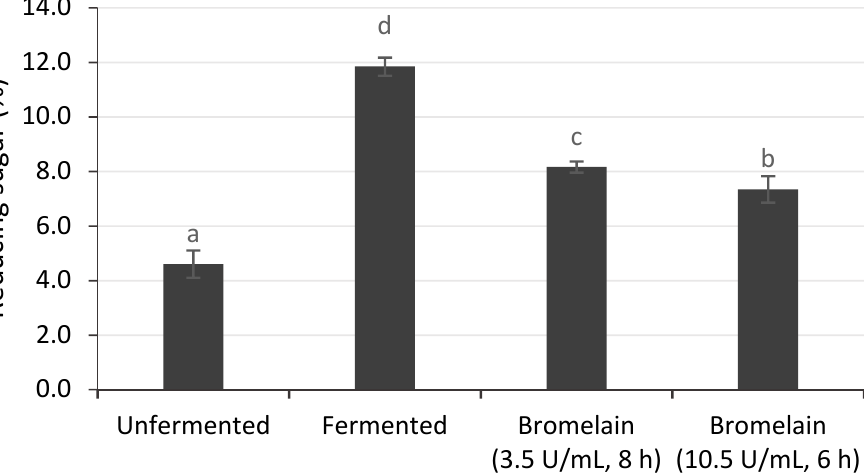
Figure 3. Reducing sugar of unfermented cocoa beans hydrolyzed by bromelain. Unfermented and fermented cocoa beans were used as controls. a–d Indicates the significant difference ( p < 0.05).